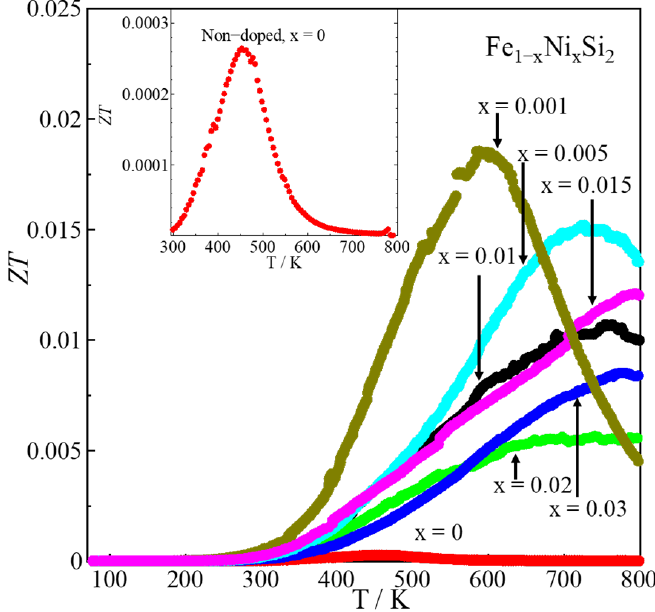
Figure 9. ZT of β -Fe 1−x Ni x Si 2 (0 ≤ x ≤ 0.03) with respect to temperature, where the inset plots the data for x = 0.